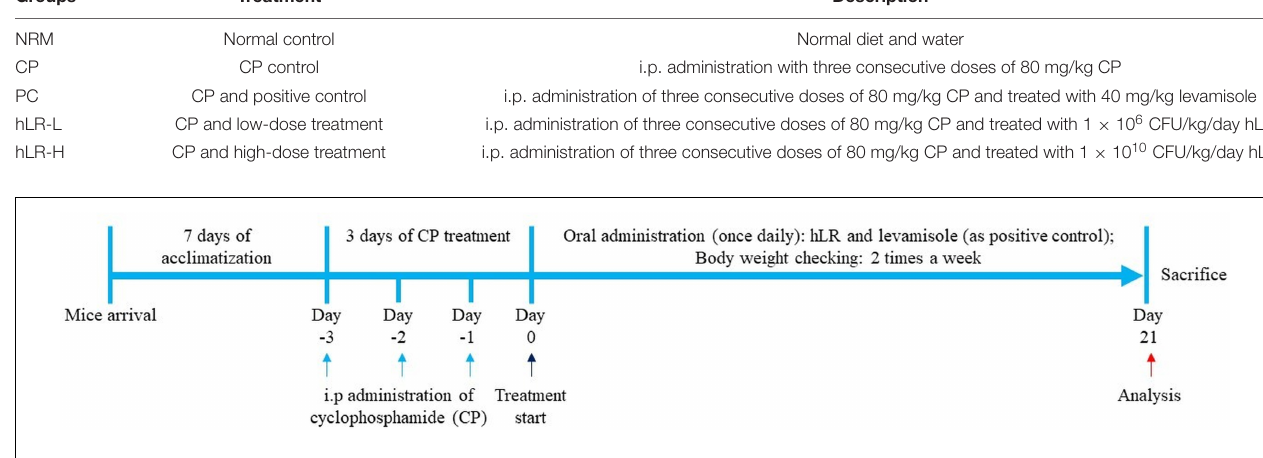
TABLE 1 | Description of different groups. Groups Treatment Description